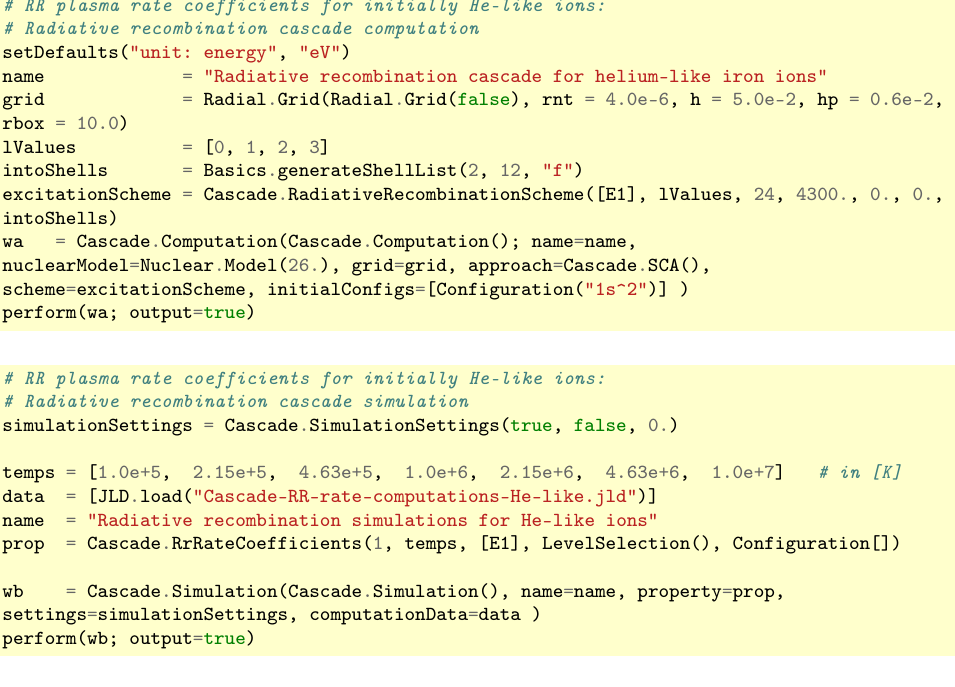
Figure 3. Input to the J AC toolbox for the cascade computation (upper panel) and simulation (lower panel) of RR plasma rate coefficients of initially helium-like Fe 24 + ions. The total plasma rate coefficients are calculated for plasma temperatures 10 5 (cid:46) T e (cid:46) 10 7 K, and by restricting the electron capture into n (cid:96) shells with n = 2 . . . 12 and (cid:96) ≤ f . While the cascade computations just generate all associated transition amplitudes, the subsequent simulation combines these data and extract the desired rate coefficients for a given set of temperatures. See the text for further